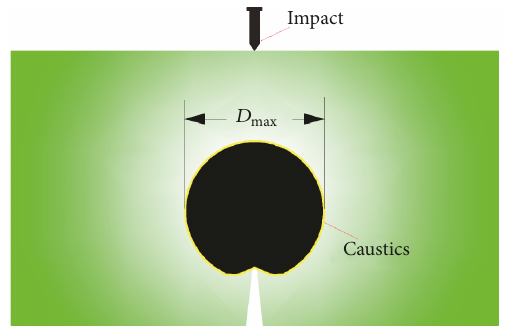
Figure 1: Diagram of caustics at a mode Ι crack